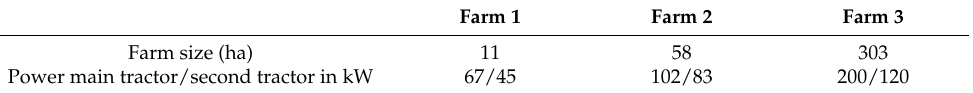
Table A1. Farm models formed from agricultural statistics [36] to investigate various variables influencing the economic success of the introduction of selected precision farming technologies.